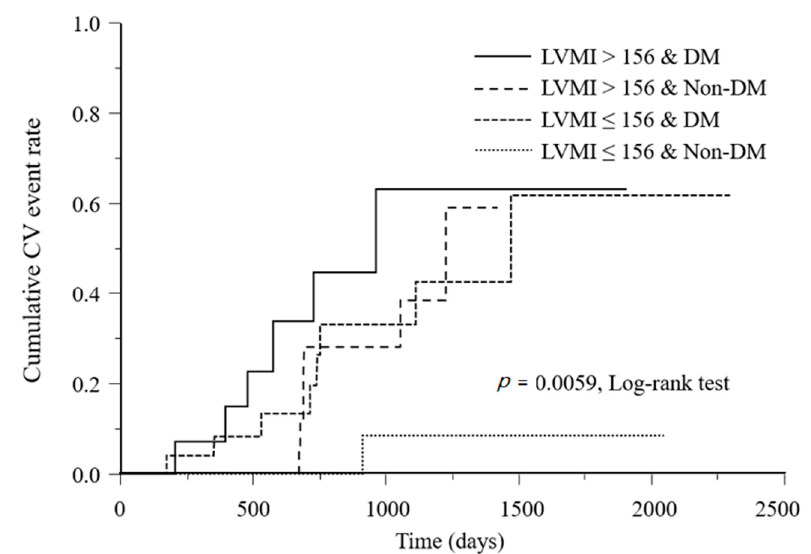
Figure 2. Kaplan–Meier analysis of CV event incidence according to LVMI class and DM. CV, cardiovascular; LVMI, left ventricular mass index; DM, diabetes mellitus. Table 3. Comparison of baseline characteristics between patients with LVMI < 156 g/m 2 and patients